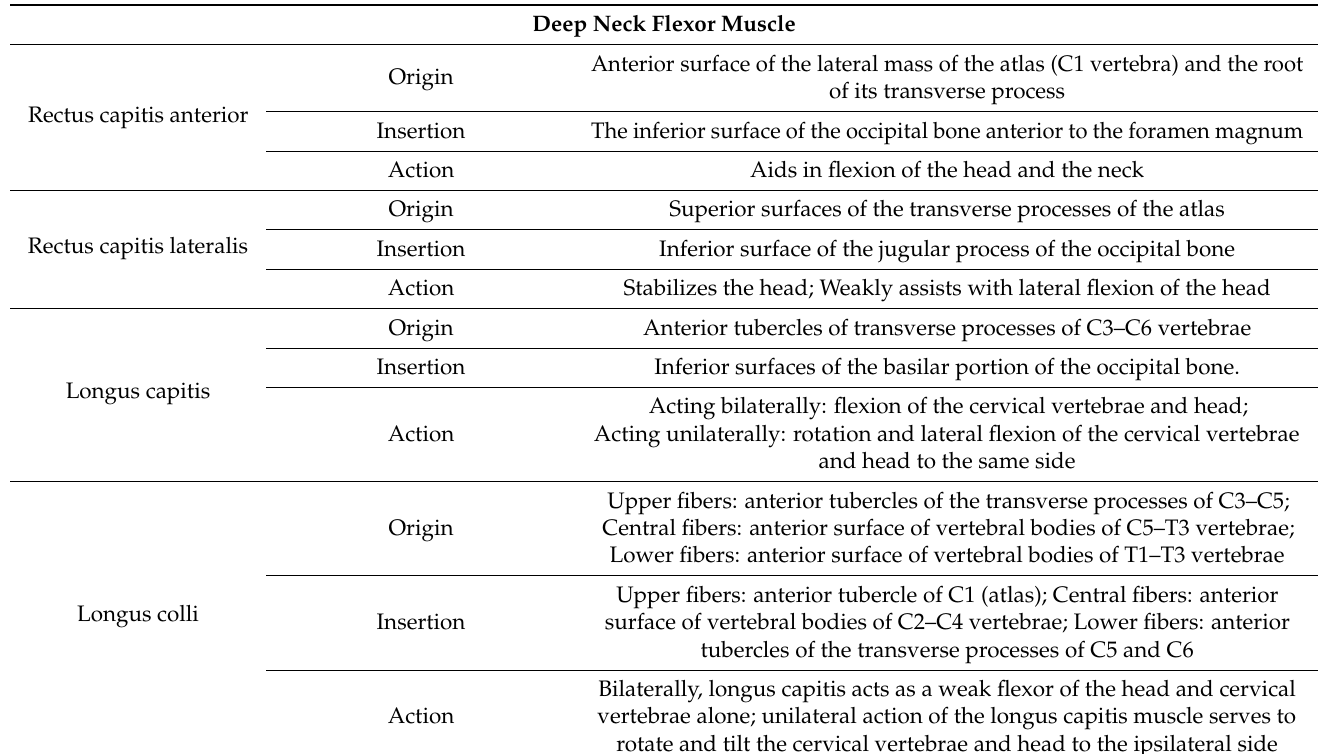
Table 1. Attachment site of deep neck flexor